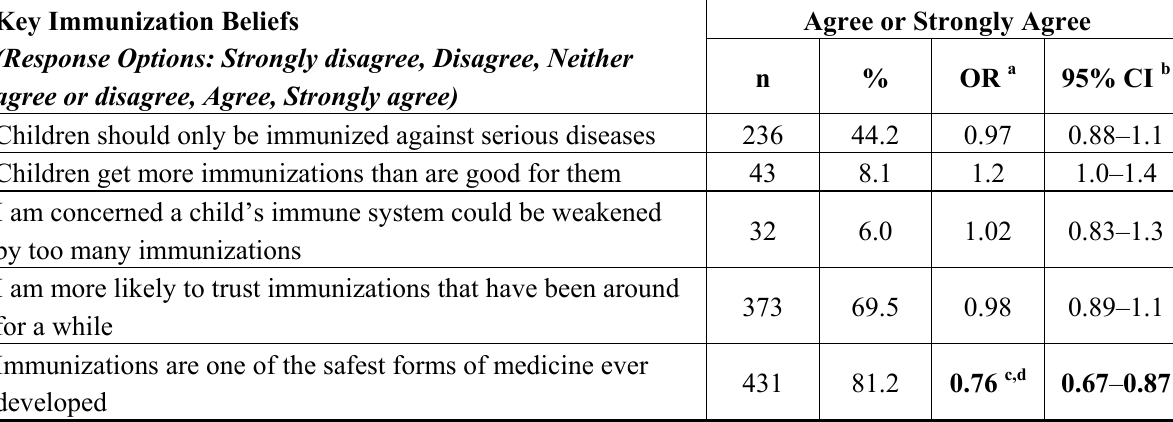
Table 2. Relationship between provider graduation year and key immunization beliefs (Adjusted for Exemption